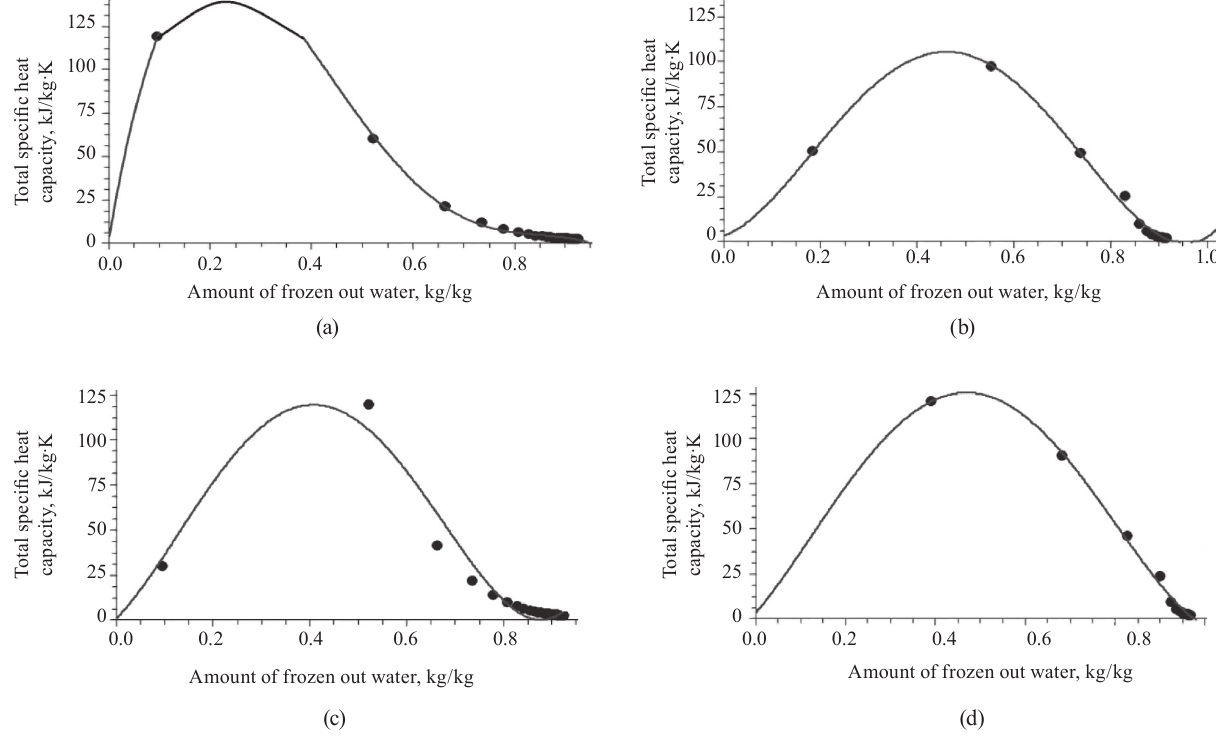
Figure 1 Relation between total specific heat capacity and the amount of frozen out water: (a) pallium of Pacific squid; (b) milt of Pacific herring; (c) octopus skin; (d) Japanese